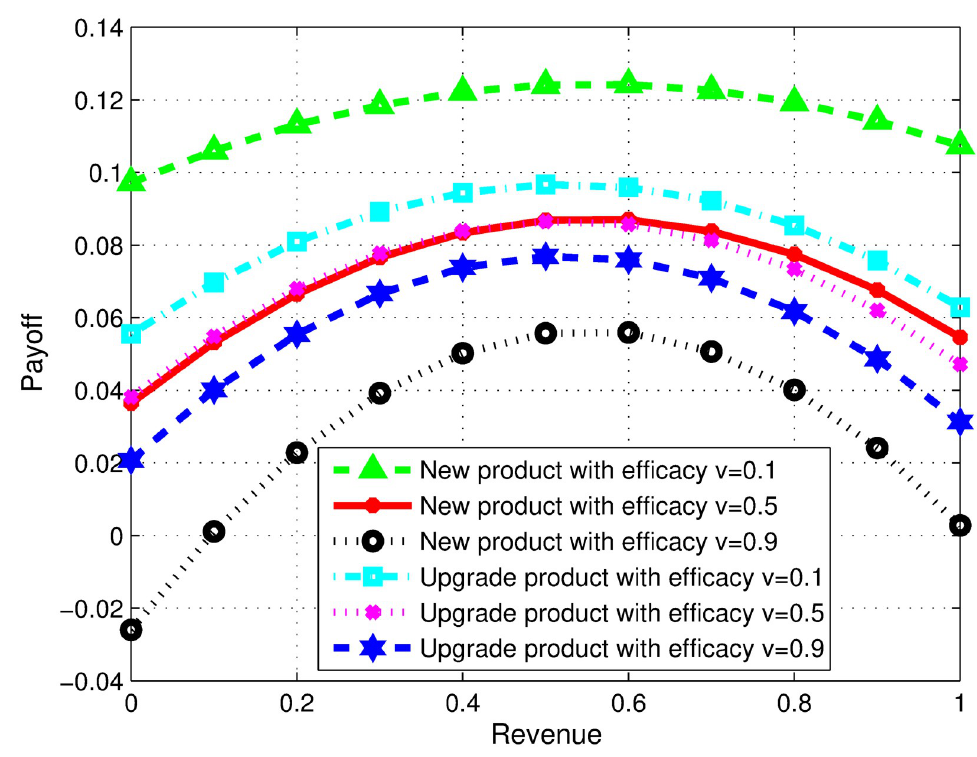
Fig 5. Impact of efficacy and product